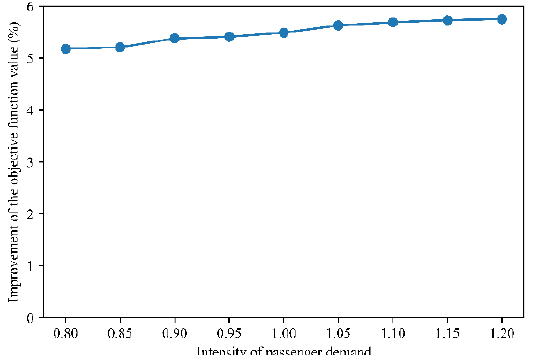
Figure 10. Optimization effect under different initial passenger demand.